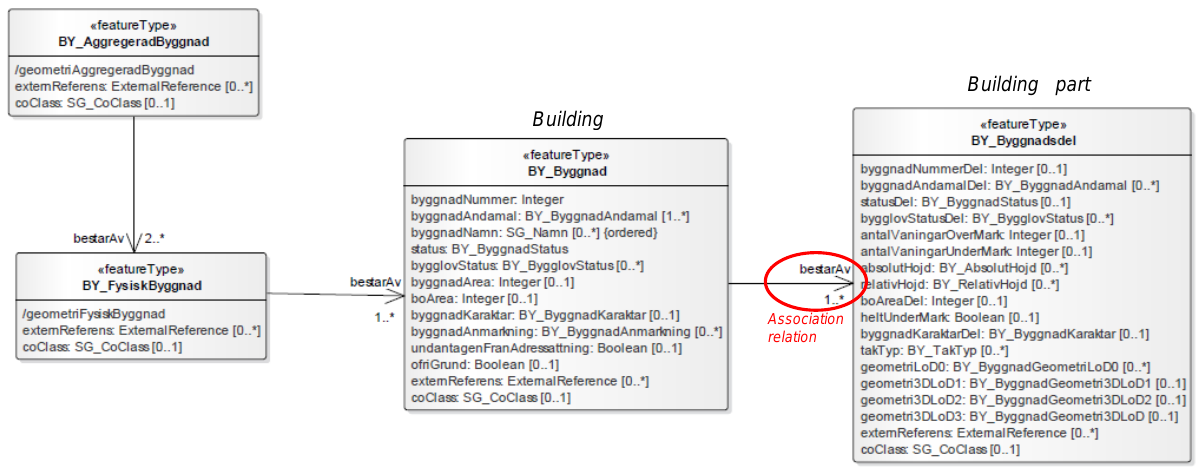
Figure 3. Building and building parts in Svensk geoprocess (SGP)